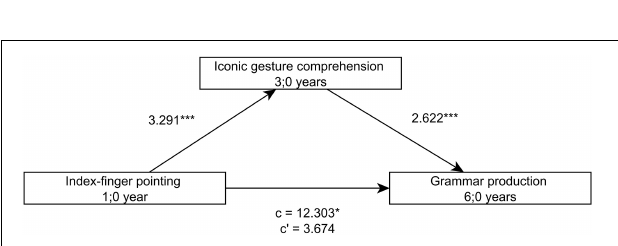
same is true for the comprehension of iconic gestures. Children